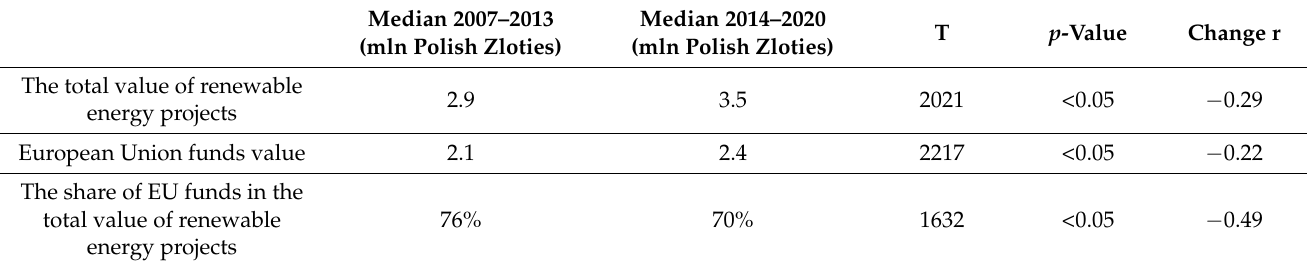
Table 7. Wilcoxon signed-rank test for analyzed